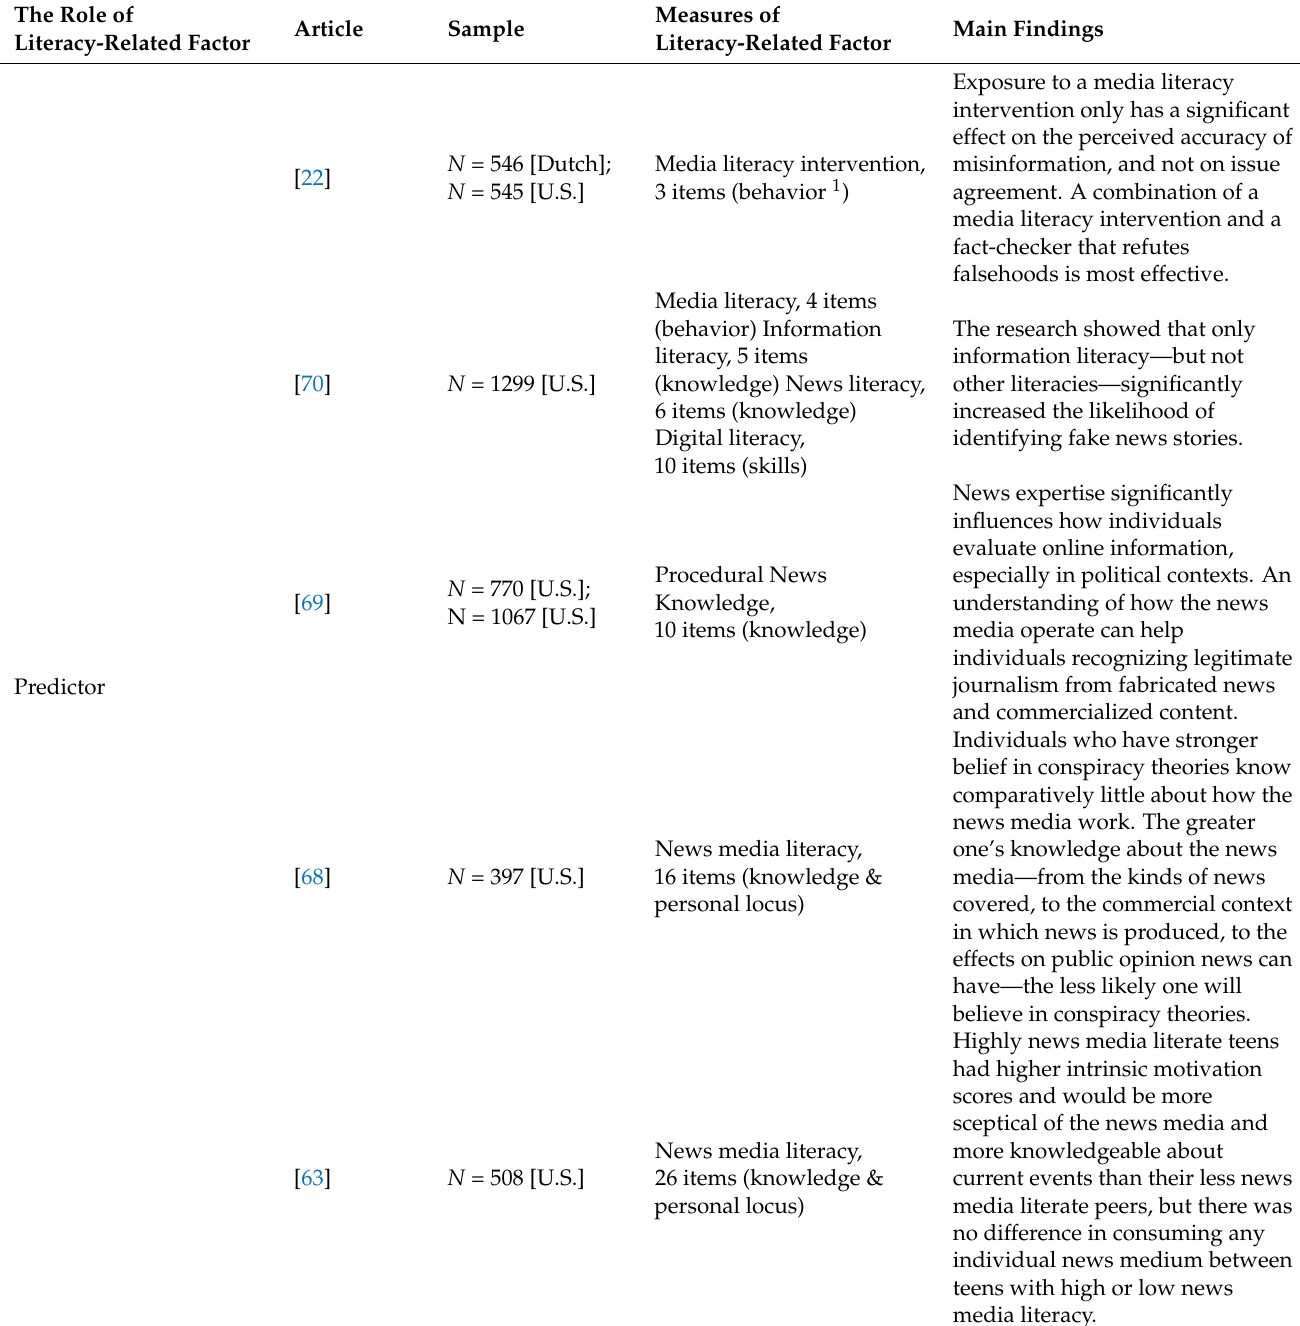
Table 1. Summary of the extant empirical studies on